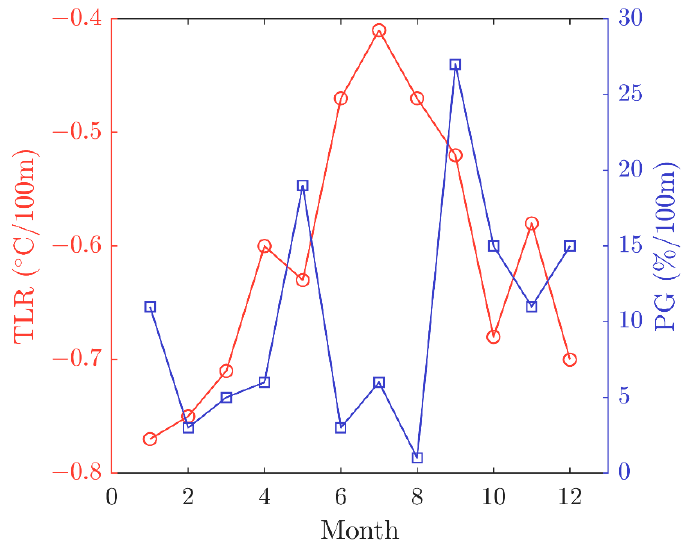
Figure 2. Temperature lapse rates (TLR, °C/100m) and precipitation gradients (PG, %/100 m) in different months.